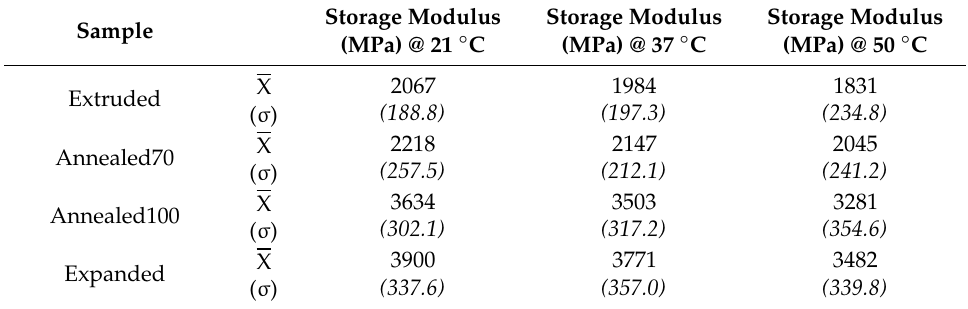
Table 3. DMA (Dynamic Mechanical Analysis) Storage Moduli at di ff erent temperatures for the Extruded, Annealed70, Annealed100 and Expanded